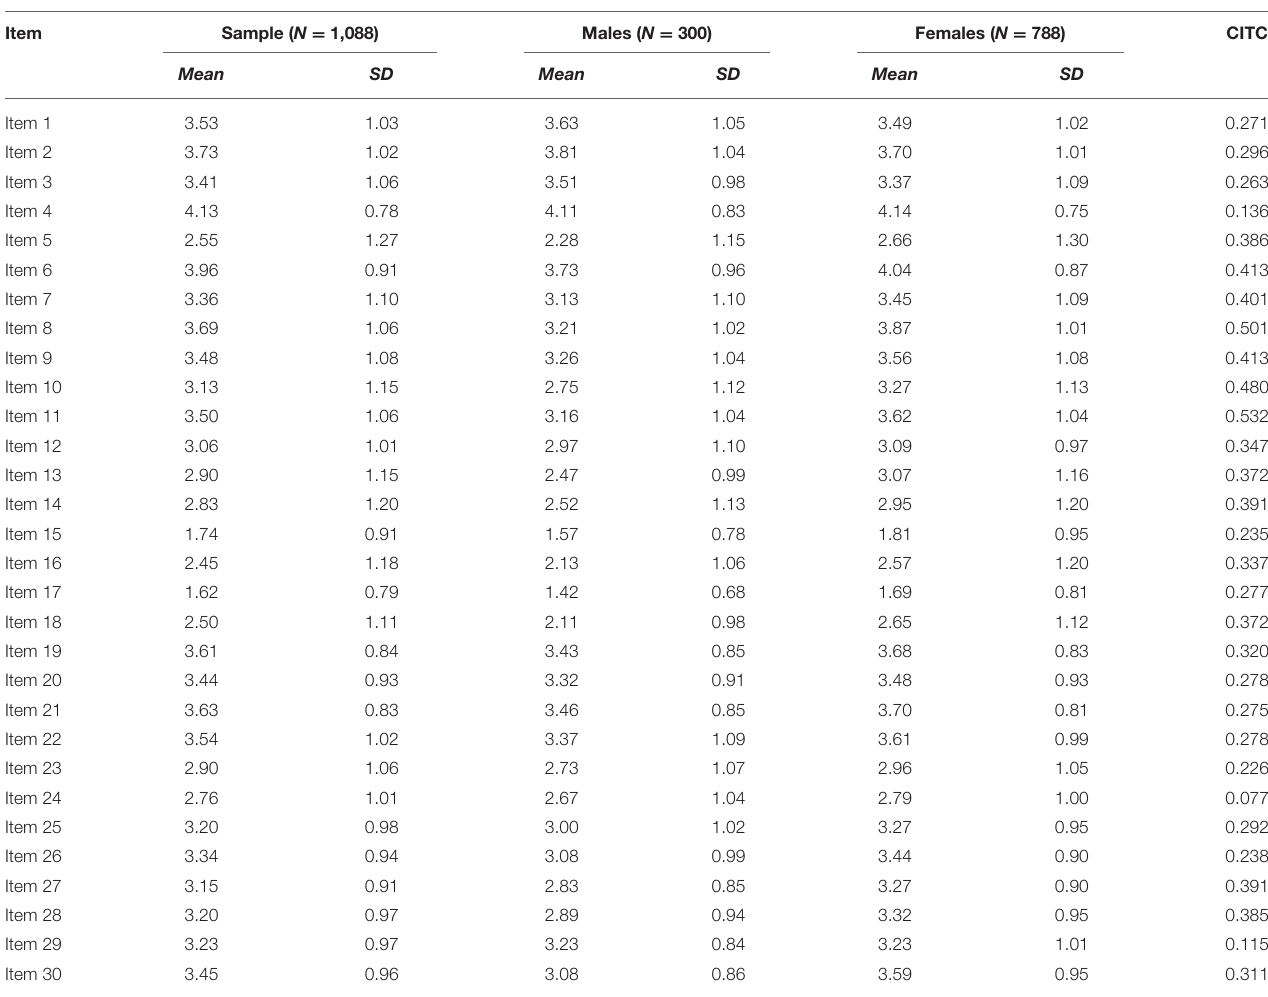
TABLE 2 | Averages and standard deviations differentiated by